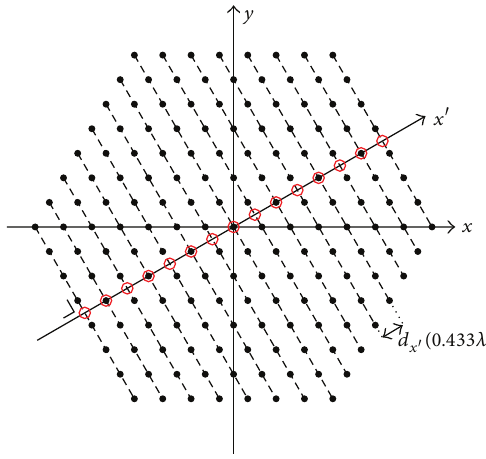
Figure 8: Collapsing the Standard Hexagonal Array-169 (with 0.5 𝜆 spacing) onto 𝜙 𝑐 = 30 ∘ yields a 0.433 𝜆 equispaced linear array of 15 elements. The element positions are indicated by the positions marked on the 𝑥 󸀠 -axis.